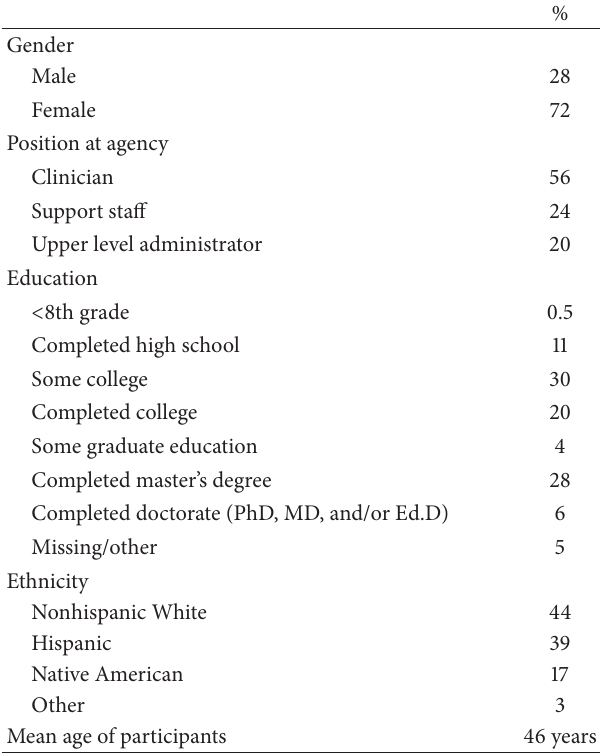
Table 1: Demographics of